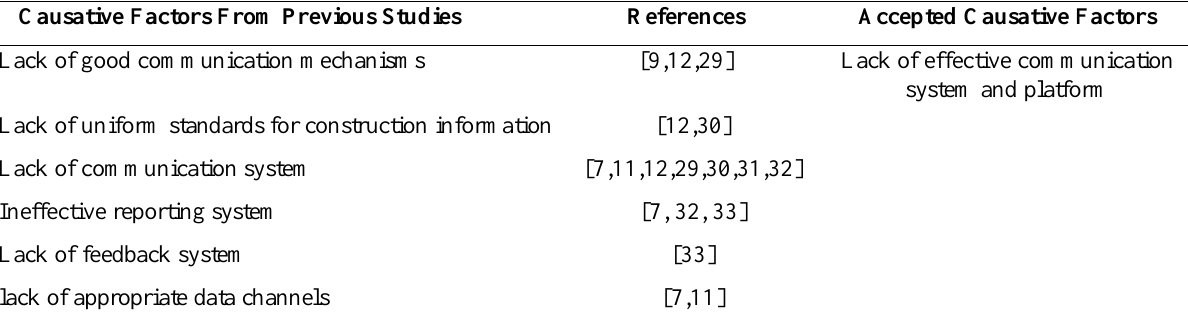
Table 1. Illustration of Similarity Analysis.